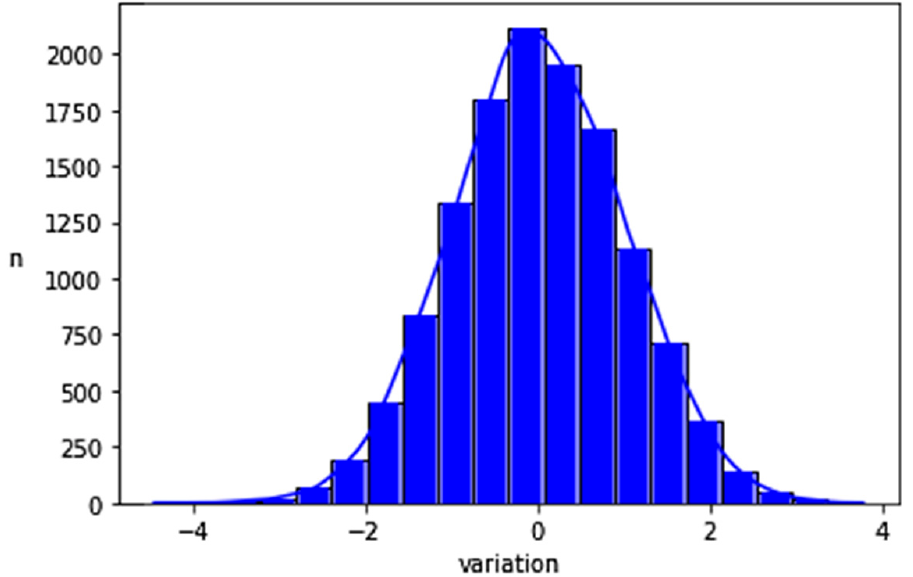
Figure 2. Histogram of the CO differences following a normal distribution. Tables 2 and 3 give examples of fictitious patients with corresponding probabilities of DgDis − and DgDis+, respectively using the mathematical model. Figure 3 plots the TPG and the CO. The diagnosis cut-off isoPVR line (2 WU) and DgDis lines corresponding to a probability of 10% and 20% are pictured. The isoPVR lines of 1 WU and 3 WU are shown in Figure